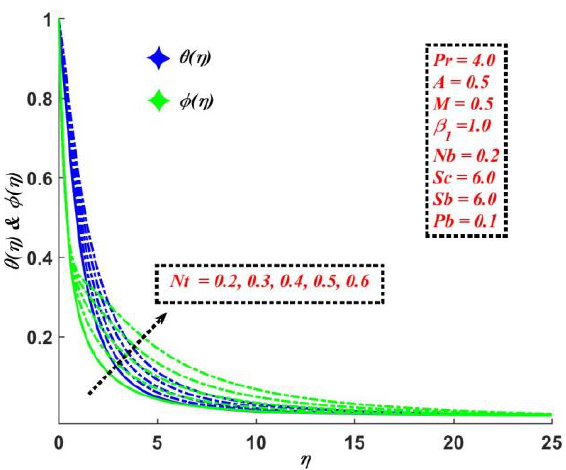
Figure 9. Influence of the thermophoresis parameter on 𝜃(𝜂) and 𝜙(𝜂) .